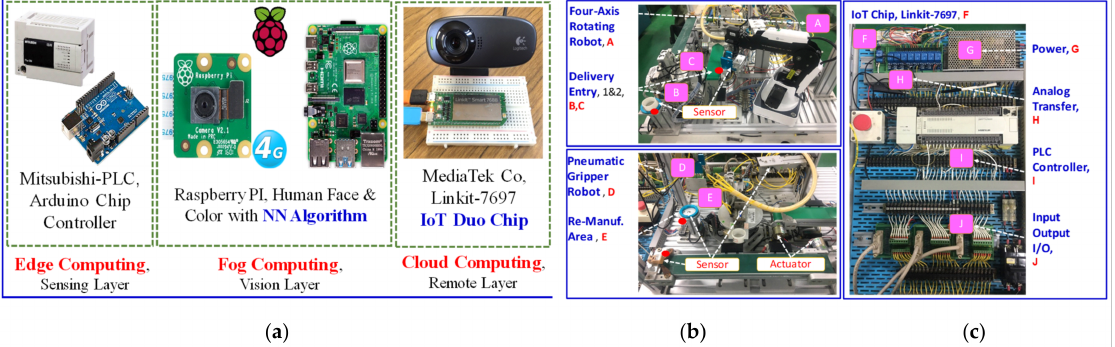
Figure 7. The platform of a physical construction for IoT of the smart factory: ( a ) edge, fog, and cloud controller entities; ( b ) gripper-type pneumatic power arm and four-dimensional robotic arm; ( c ) power and controller